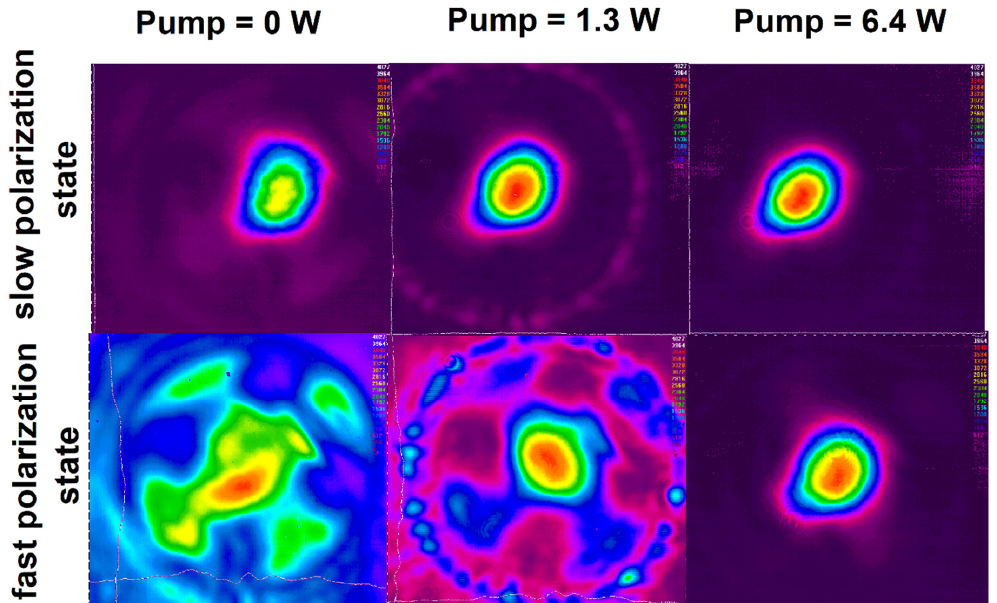
Figure 6. Mode field intensity distribution for slow- and fast-polarization states of the fundamental mode at different pump powers.